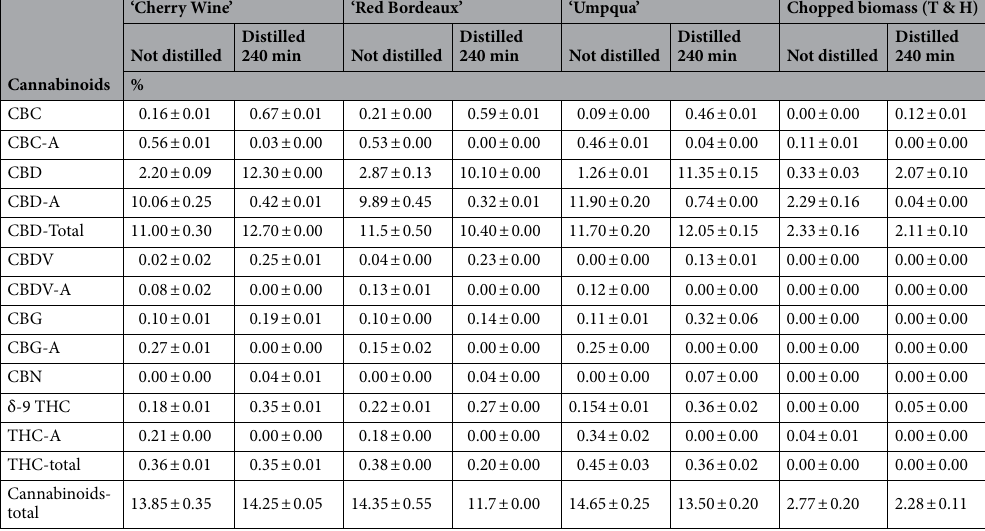
Table 2. Cannabinoid content (%) in distilled and not distilled biomass of 4 varieties, transplanted autoflower type hemp plants (mean ± std.err.; n = 2).